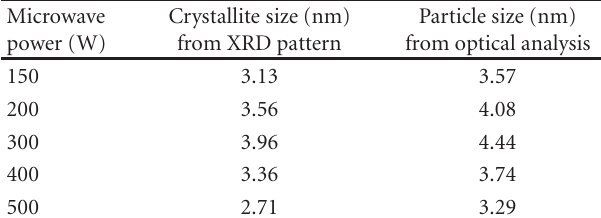
Table 1: Comparison of crystallite size calculated by Deby Scherrer equation and particle size calculated from optical analysis.